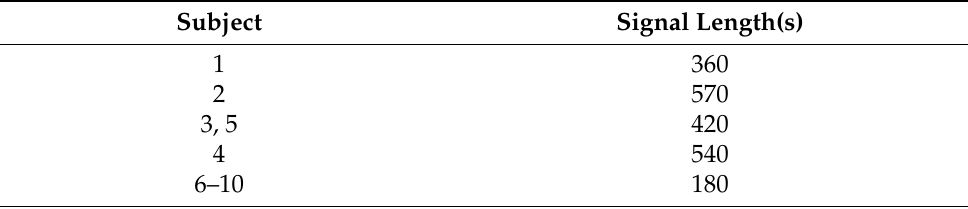
Table 2. The signal length of subject